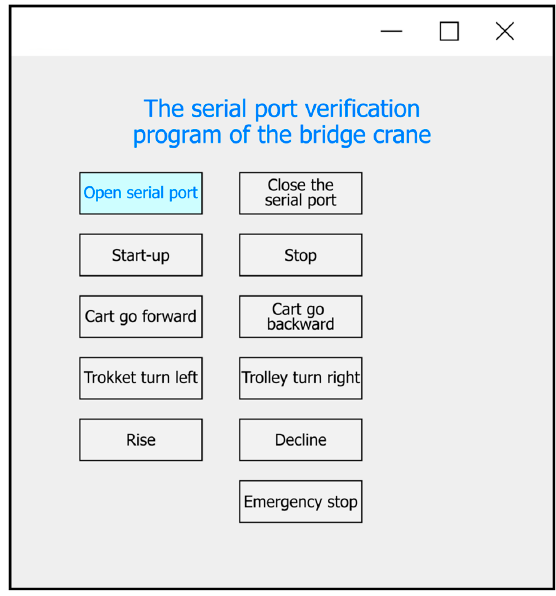
Figure 7. The fi nal running e ff ect of the software. Figure 7. The final running effect of the